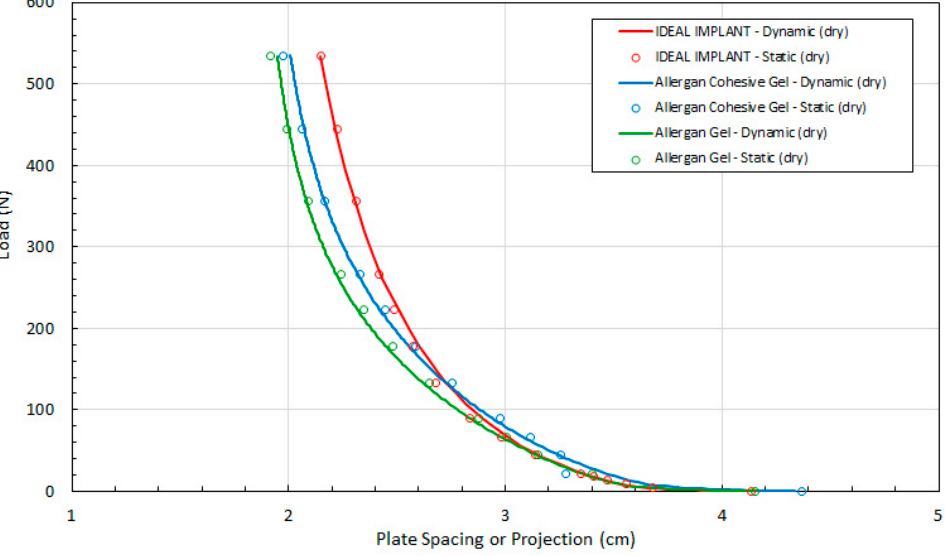
Figure 4. Load (F) as a Function of Plate Spacing (H) for Static and Dynamic Testing and Dry Platens.